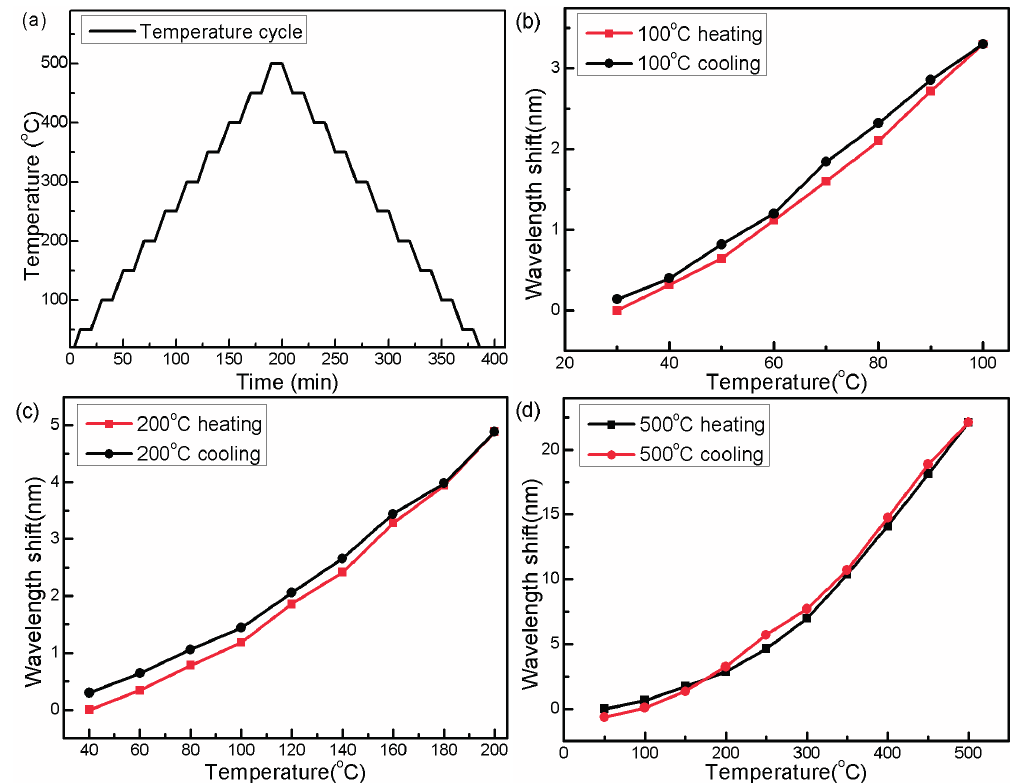
Figure 6. ( a ) Temperature cycle operation. Interference dip wavelength versus the temperature during the different cycles with the maximum temperature of ( b ) 100 °C, ( c ) 200 °C and ( d ) 500